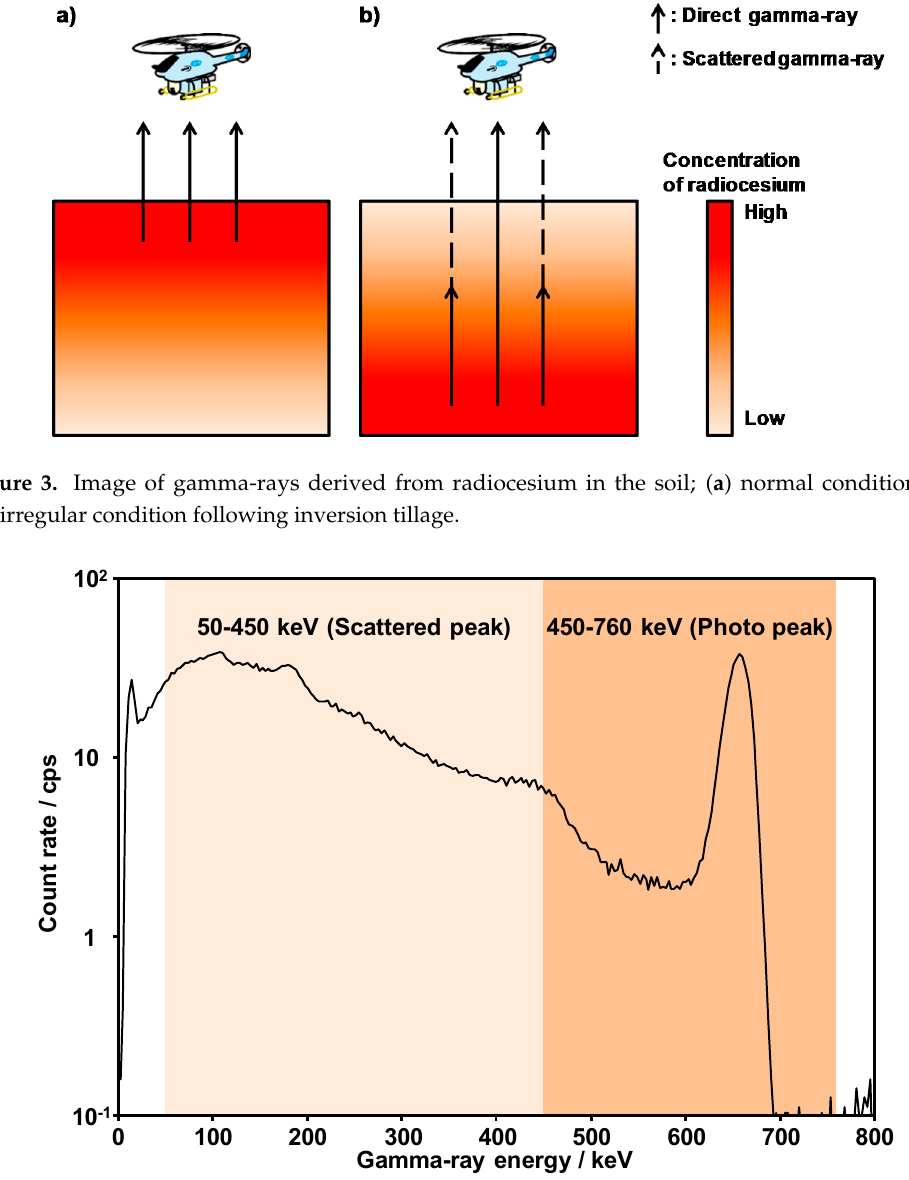
Figure 4. Conceptual schema for dividing the gamma-ray spectrum obtained from the LaBr 3 :Ce detector into two sections.